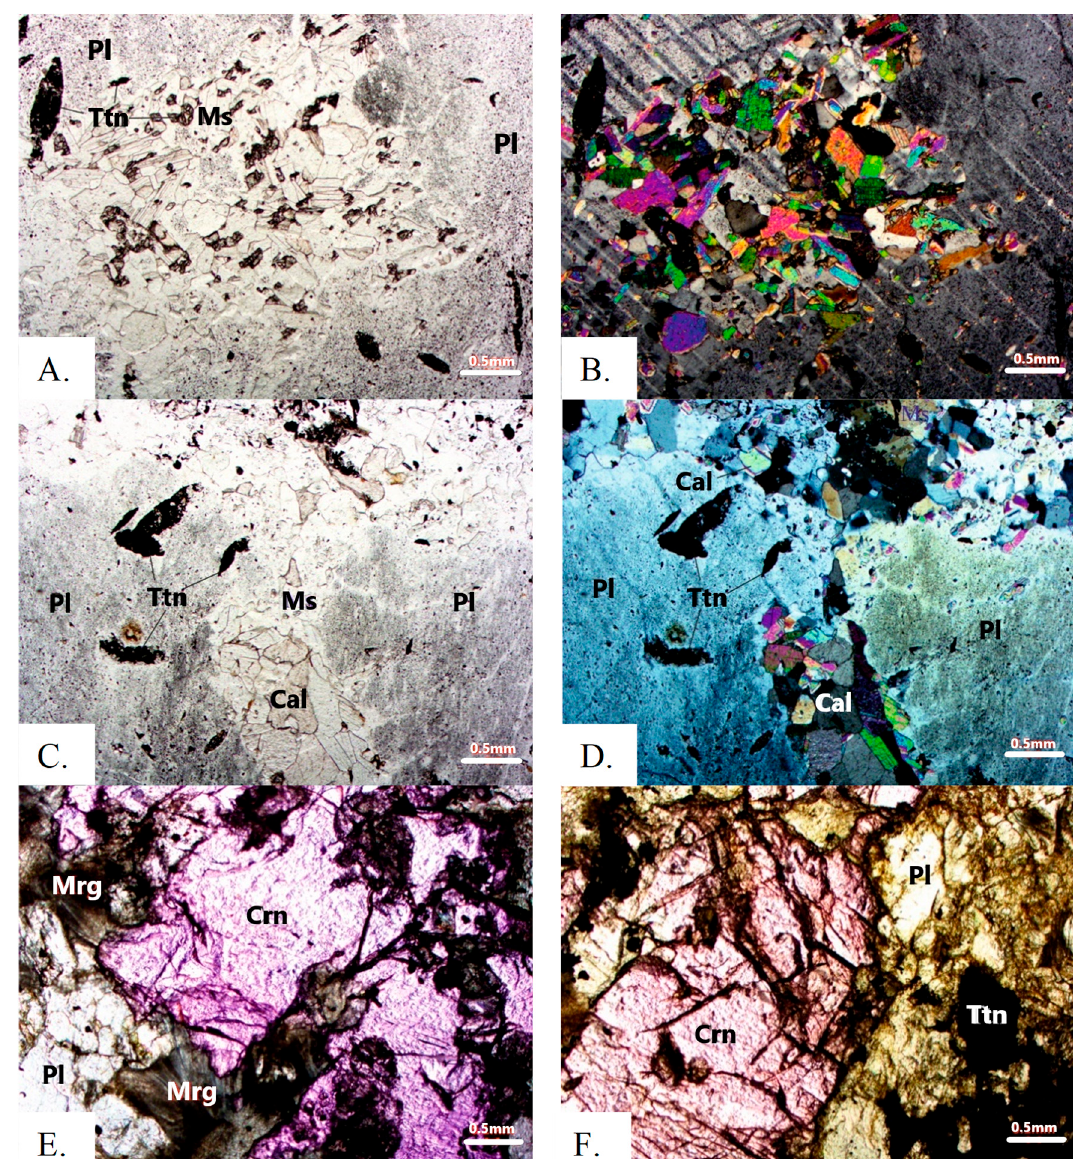
Figure 5. Petrographic thin-sections of titanite (Ttn), muscovite (Ms) and calcite (Cal) grains intergrown with larger plagioclase (Pl) crystals in plane-polarized light ( A , C ) and under crossed-polarized light ( B , D ); corundum (Crn) intergrowths with margarite (Mrg) and plagioclase crystals ( E , F ), plane-polarized light.